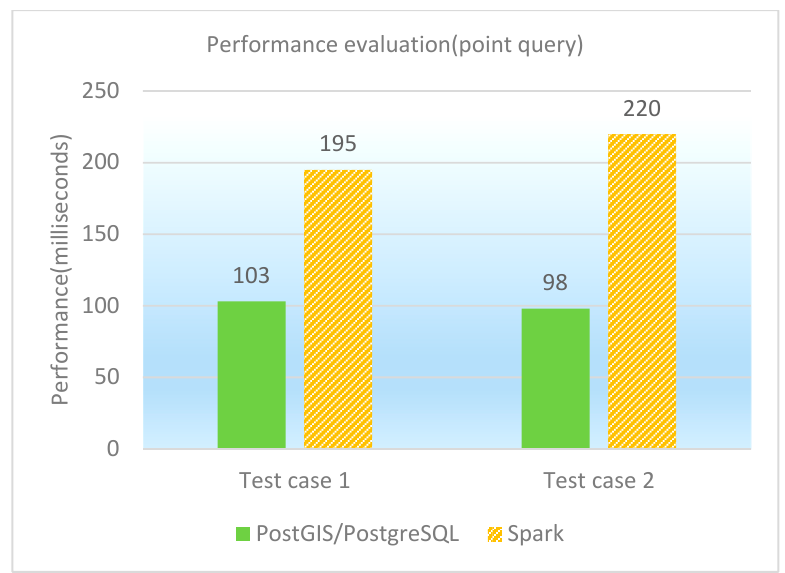
Figure 7. Performance comparison graph of point queries (in milliseconds).